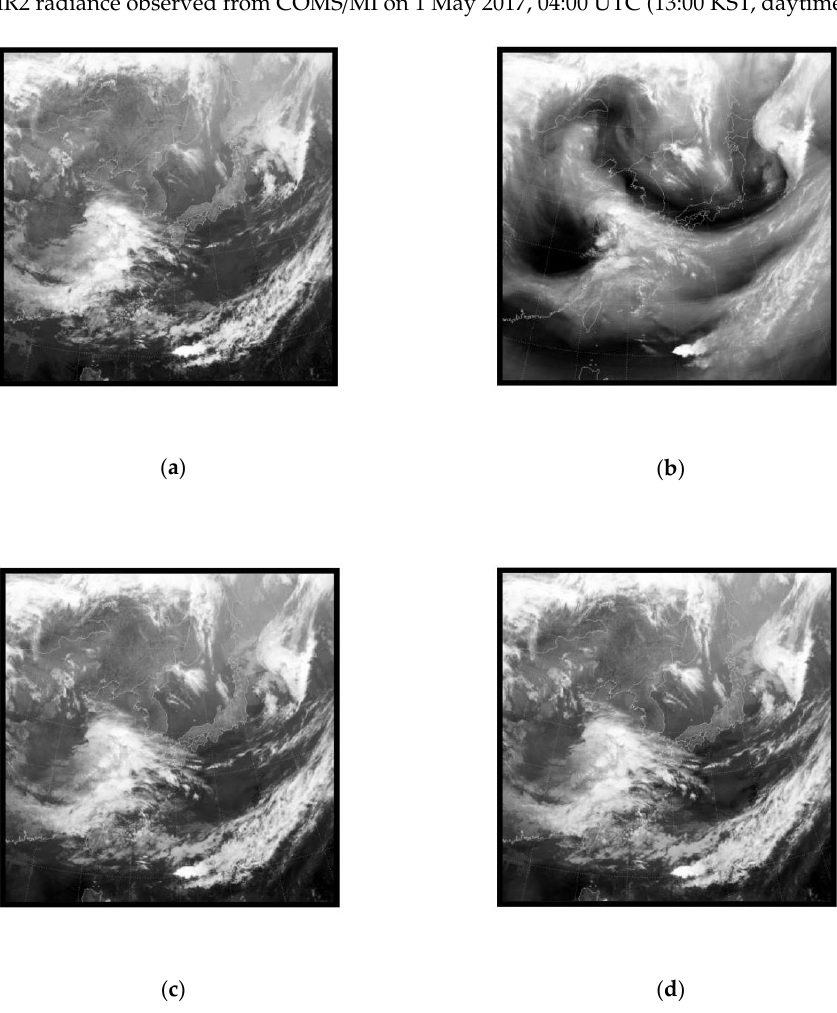
Figure 3. Radiances at ( a ) MWIR, ( b ) WV, ( c ) IR1, and ( d ) IR2 bands of COMS / MI on 1 May 2017, 16:00 UTC (May 2, 2017, 01:00 KST,